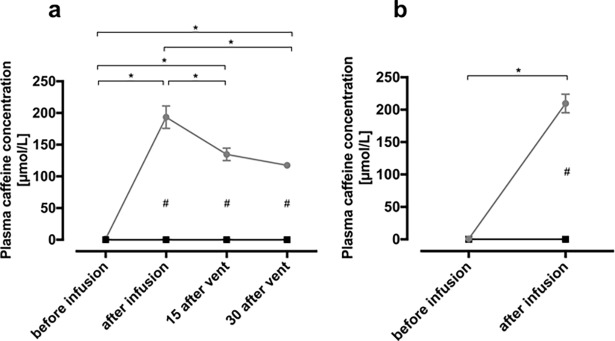
Arterial plasma caffeine concentration in lambs (a) and ewes (b) before and after caffeine/ saline infusion and at 15 and 30 minutes after ventilation onset (only in lambs). # indicates significant difference between groups. * indicates significant difference within the caffeine group. Data are presented as mean± SEM.